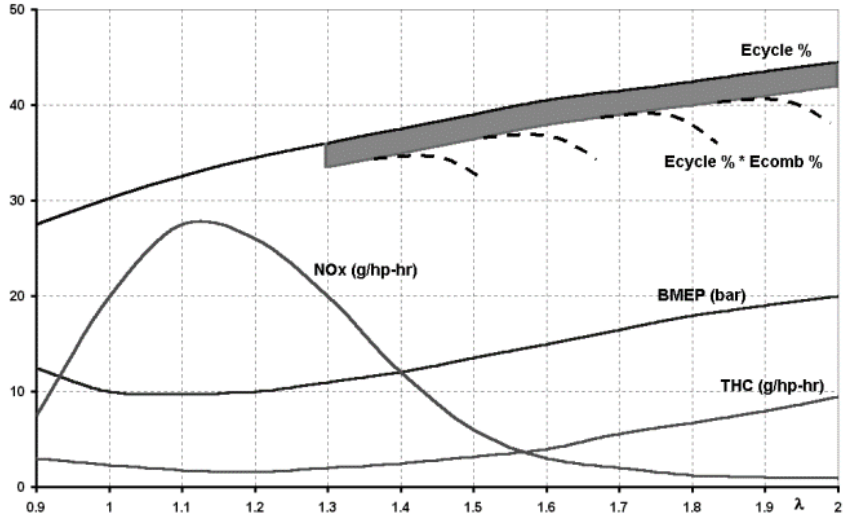
Figure 13. Effect of air–fuel ratio of natural gas [205].